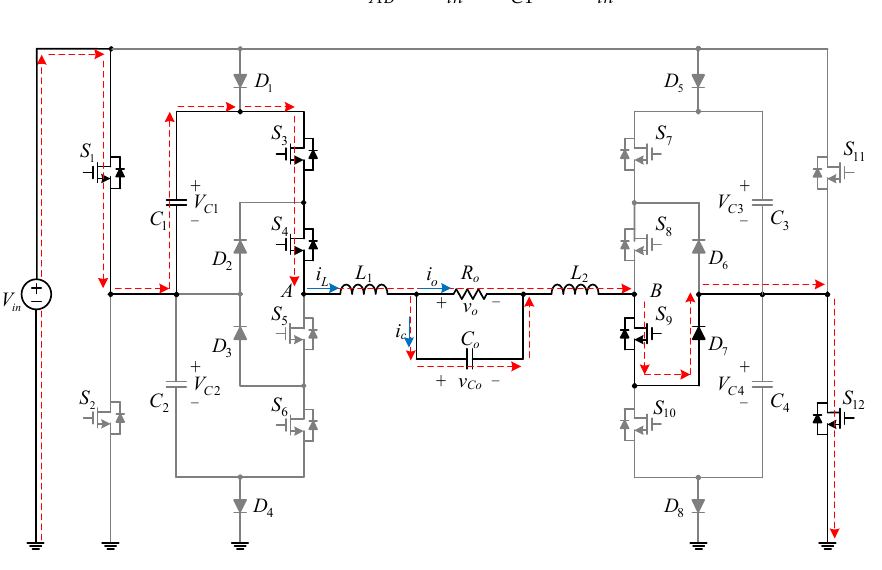
Figure 7. Gate driving signal for S 3 . Interval [ t 3 ≤ t ≤ t 4 ] : The switches S 1 and S 3 are on, but the switch S 4 is off. As shown in Figure 8, the current flowing through the inductors L 1 and L 2 will form a circuit loop from the input voltage to S 1 , S 3 , S 4 , S 9 , S 12 and the diode D 7 ; therefore, the voltage across the terminals A and B is